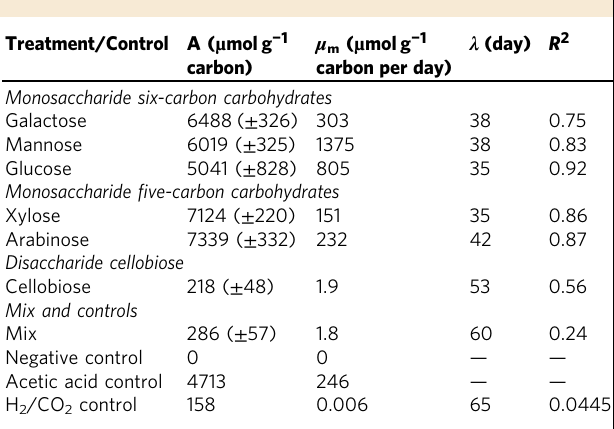
Table 1 Methane production kinetic parameters for a 128-day incubation period of anaerobic microcosms inoculated with PRB coal